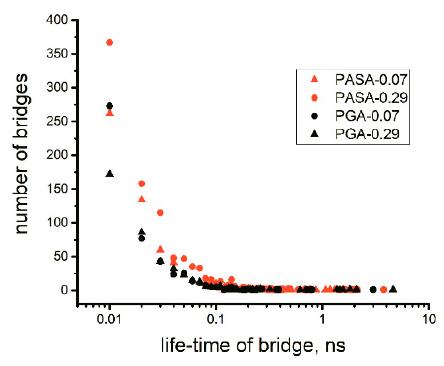
Figure 4. The distribution of calcium bridge lifetimes in the highest replica (replica number 21 in Table 2) without exchanges (data from the equilibration stage).